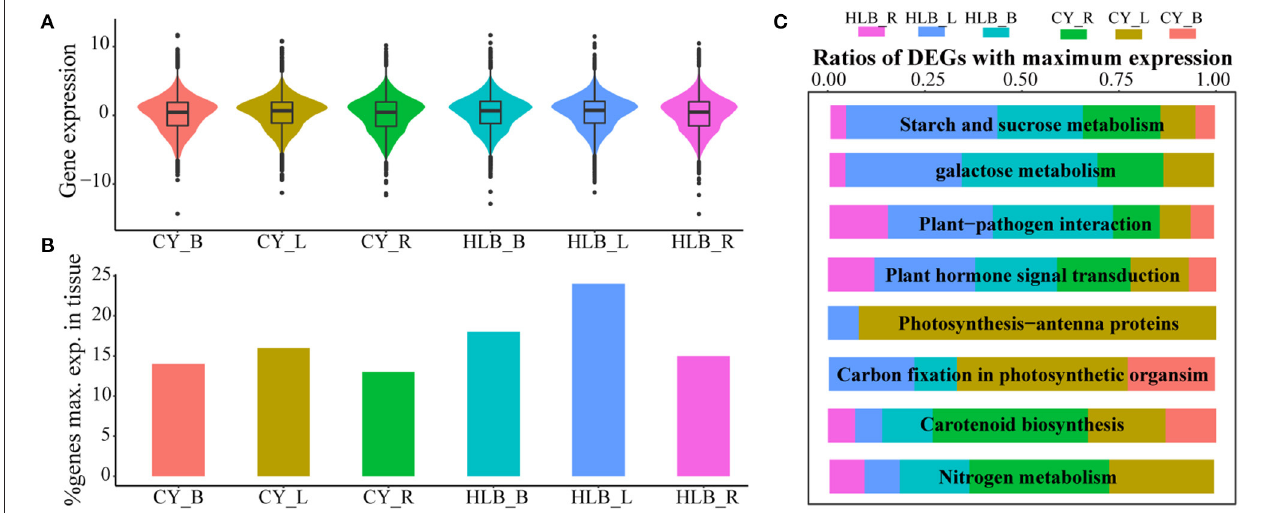
FIGURE 5 | Relative gene expressions among all tissues. (A) Gene expression distributions among all tissues; (B) comparison of the expressed gene number with maximal expression among the three tissues. Genes of each tissue with maximal expression are computed based on average expression values across biological replicates; (C) relative ratios with maximal gene expression among eight typical HLB-affected pathways in all the